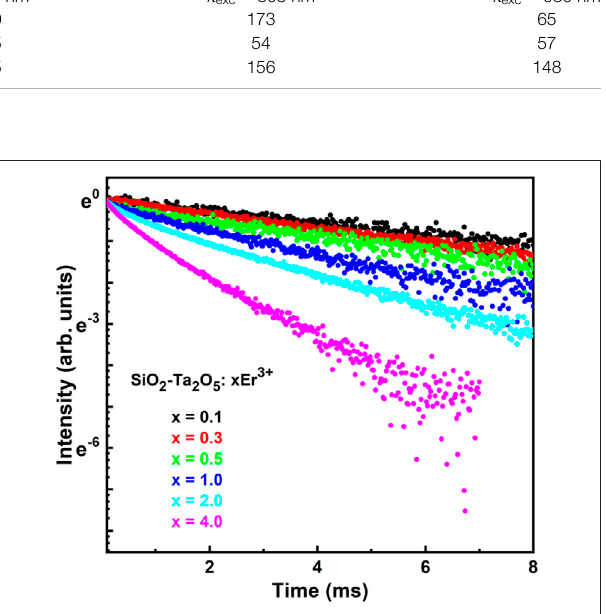
FIGURE 9 | Emission spectra in the infrared region of the 0.03, 0.1, 0.3, 0.5, 1, 2, and 4 mol% Er 3+ -doped SiO 2 -Ta 2 O 5 nanocomposites calcined at 1100 ° C for 8 h, under excitation at 980 nm with 100-mW power pump.